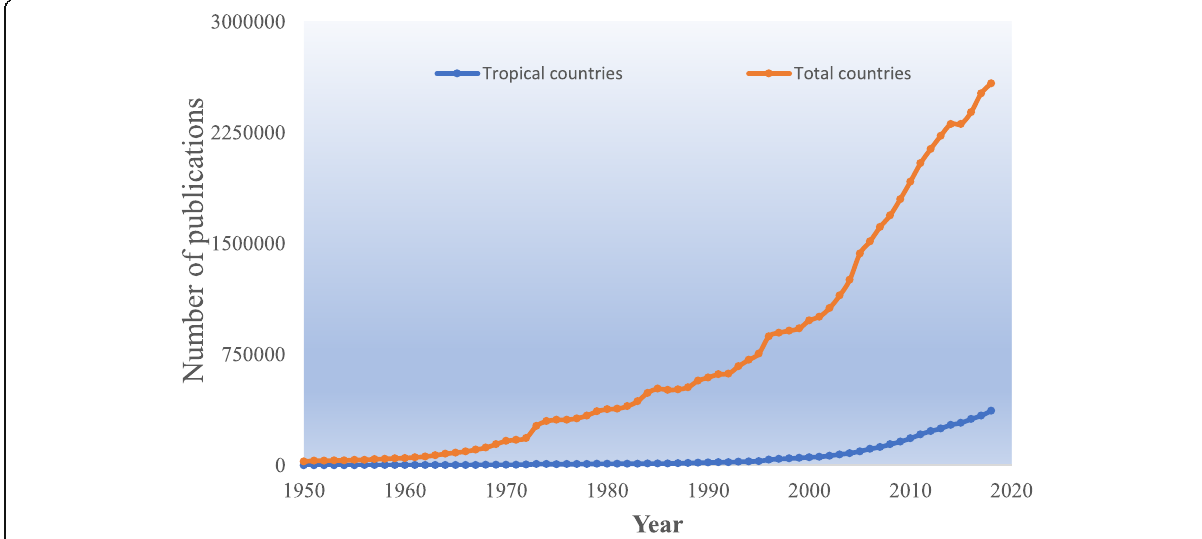
Fig. 1 Number of publications with authors from tropical countries compared with the total number of